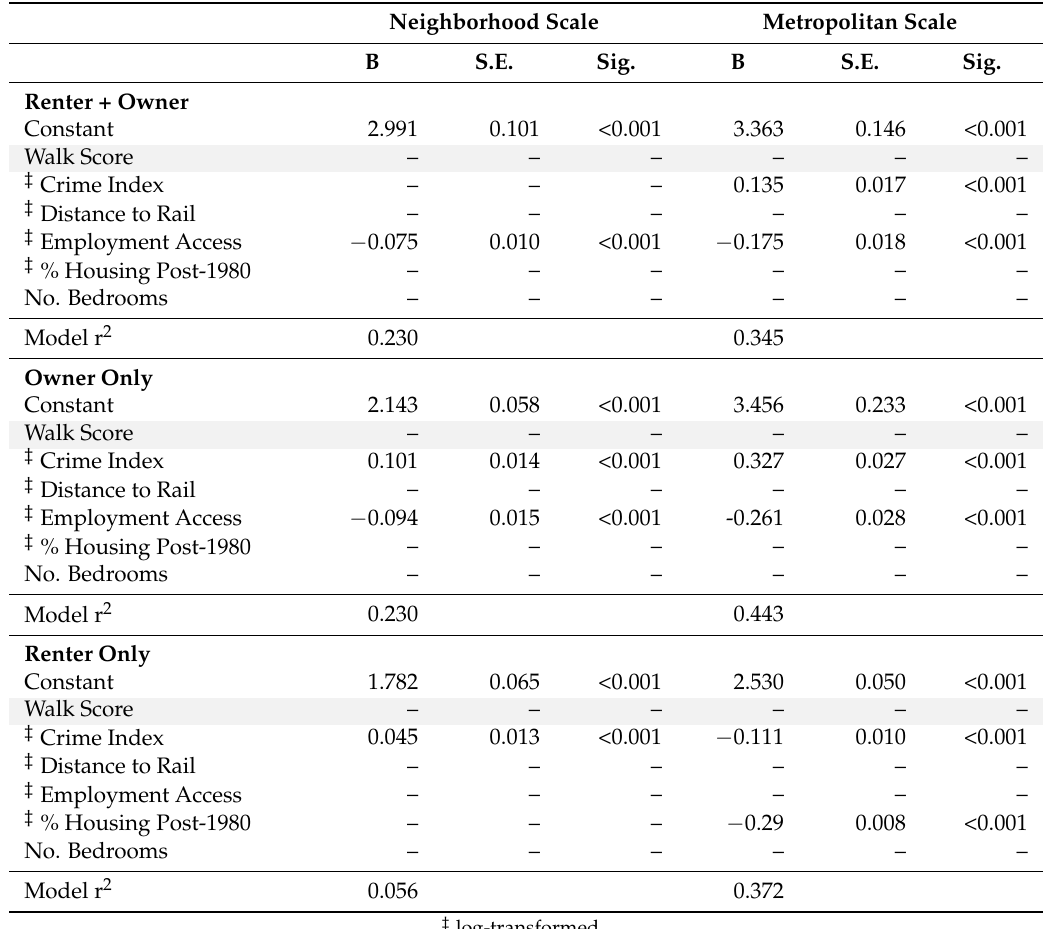
Table 2. Results of the OLS regression analyses (stepwise procedure) for the Charlotte, NC urbanized area, with the log (10) of the combined renter and owner (CHAI), owner only (HAI), and renter only (RAI) housing affordability indices as the dependent